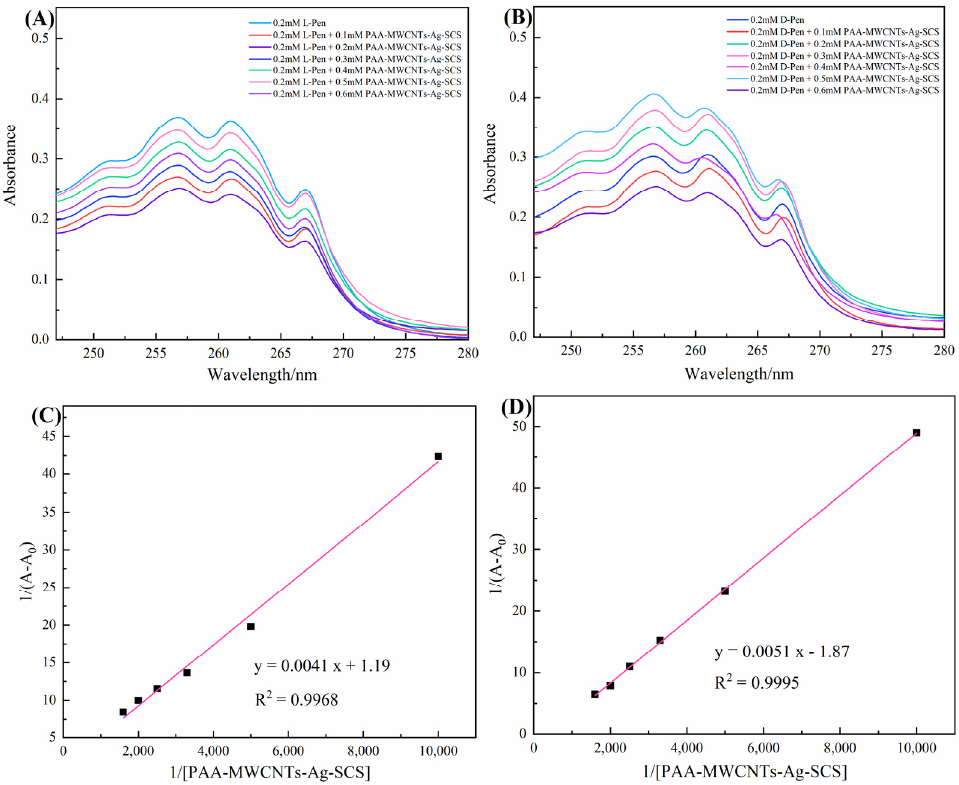
Figure 8. UV spectra of 0.2 mM L-Pen ( A ) and D-Pen ( B ) after the addition of various PAA- MWCNTs-Ag-SCS concentrations (the amount-of-substance concentration of PAA-MWCNTs-Ag- SCS is replaced by the concentration of silver-ammonia ions). Double reciprocal plots of L-Pen ( C ) and D-Pen ( D ) (pH = 7). (pH =